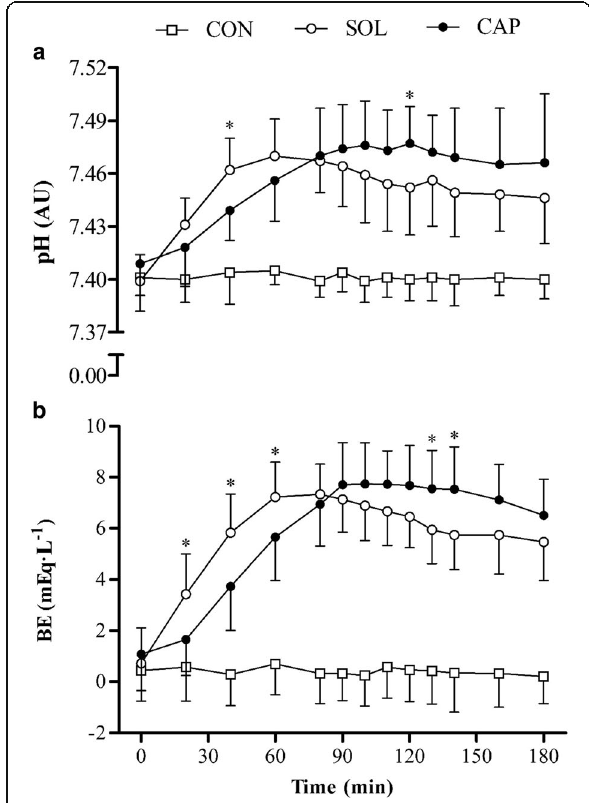
Fig. 4 Mean (±SD) pH ( a ) and BE ( b ) responses. The asterisk denotes significant difference between SOL and CAP conditions ( P